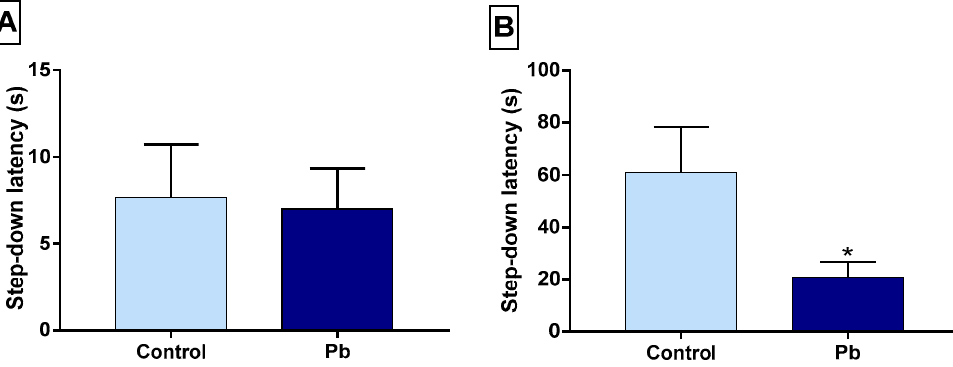
Figure 2. Effects of long-term exposure to Pb on step-down inhibitory avoidance. ( A ) step-down latency time (s) in the training session; ( B ) step-down latency time 24 h later. * p < 0.05 compared to the control group (Student's t-test).